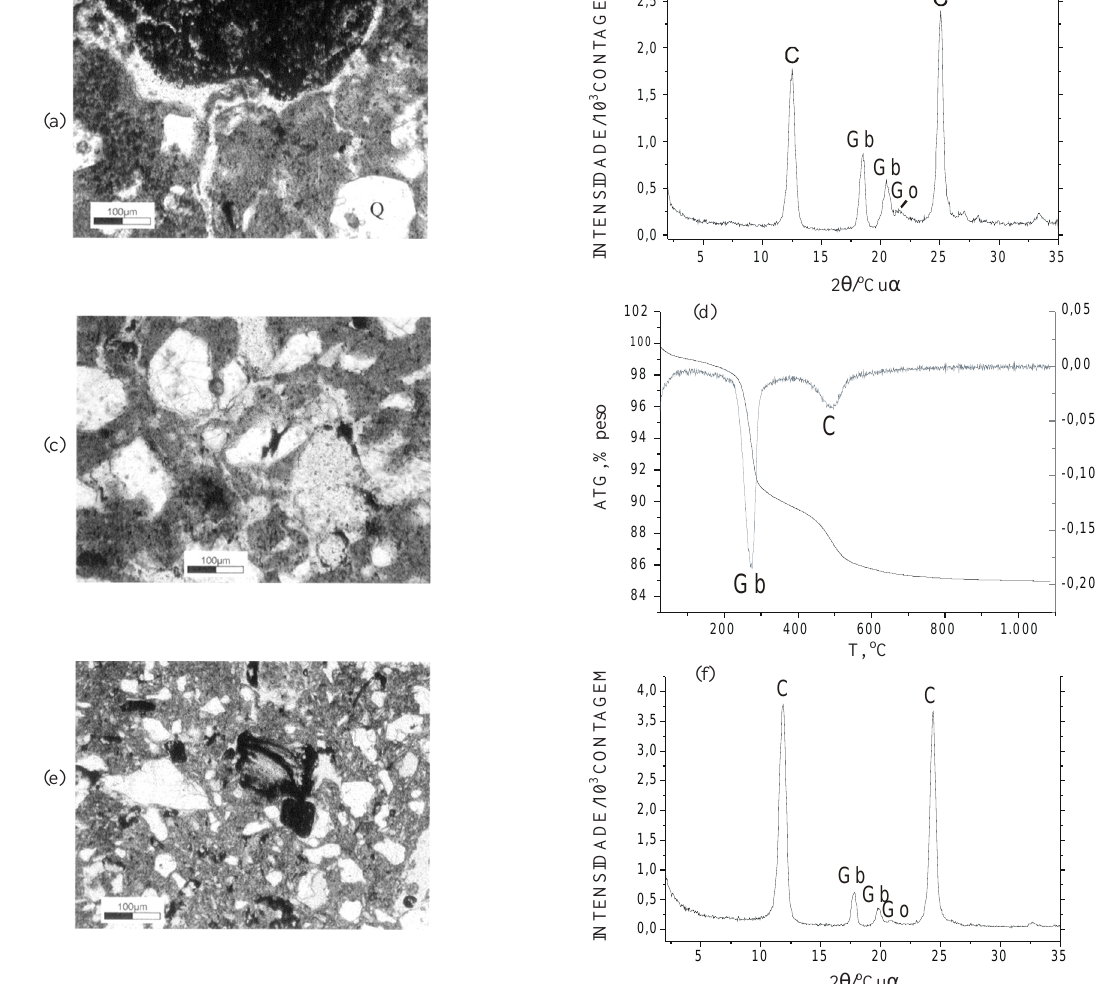
Figura 6. Aspectos micromorfológicos e mineralógicos da toposseqüência 3. (a) = Fotomicrografia em luz plana do horizonte B de VOVH1. (b) = DRX do horizonte B de VOVH1. (c) = Fotomicrografia em luz plana do horizonte B de VOVH2. (d) = ATG e sua derivada do horizonte B de VOVH2. (e) = Fotomicrografia em luz polarizada do horizonte C de VOVH3. (f) = DRX do horizonte C de VOVH3. C = caulinita, Gb = gibbsita, Go =